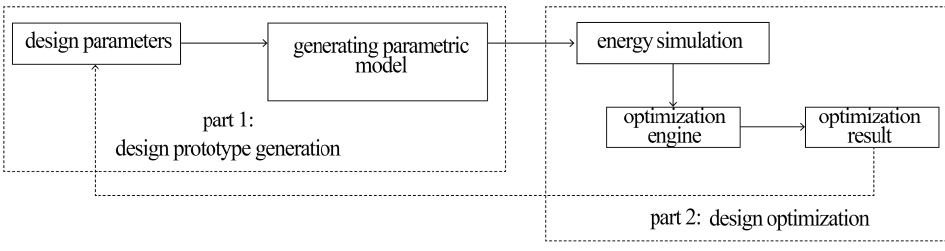
Figure 6. Simulation based modeling and optimization process.